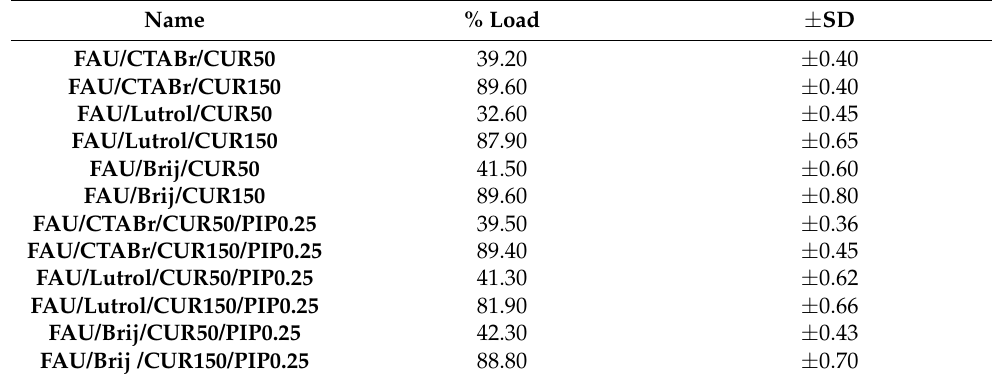
Table 5. Curcumin loading into hierarchical